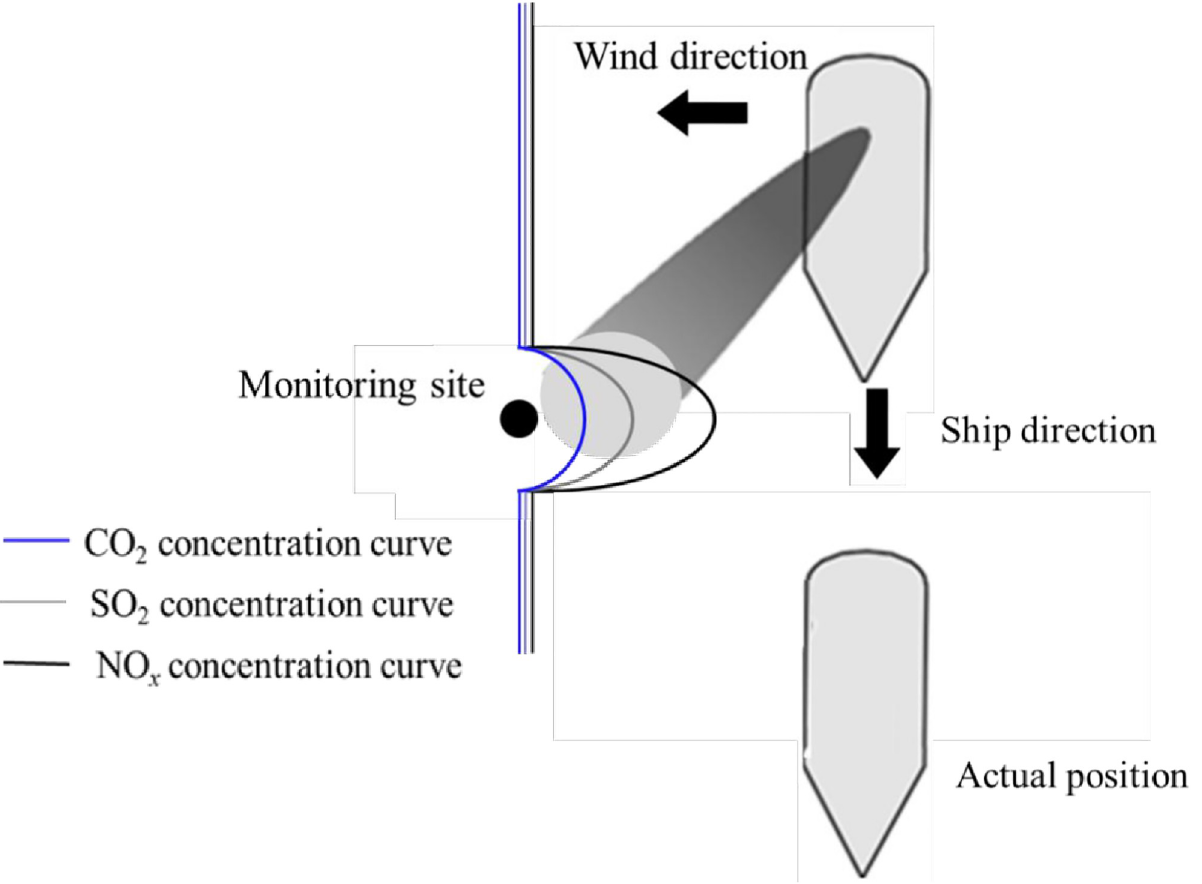
Fig 1. The schematic and the profile of the sniffer